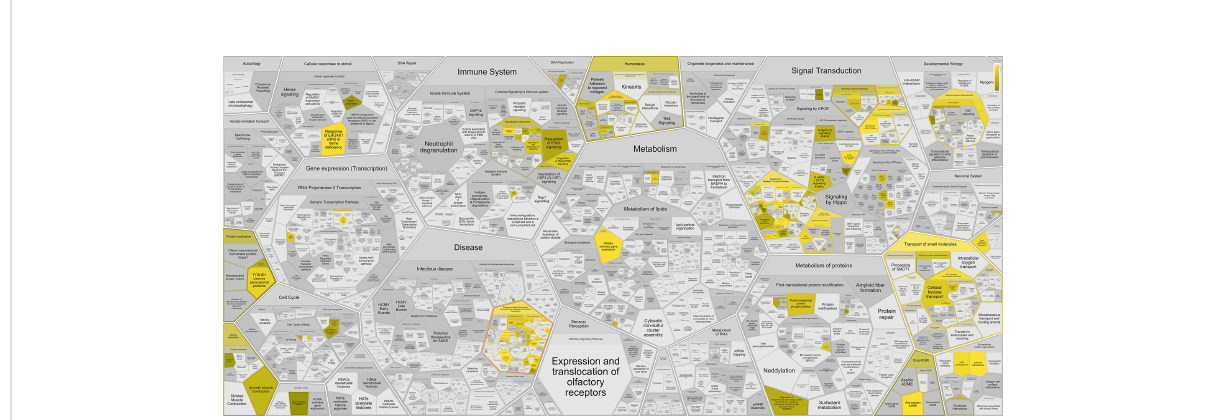
FIGURE 1 Graphical representation of the main Reactome pathways enriched in the target genes from hsa-miR-223-5p. The intensity of the color is related to the statistical signi fi cance of the miRNA involvement, while the cell size is related to the number of genes in each